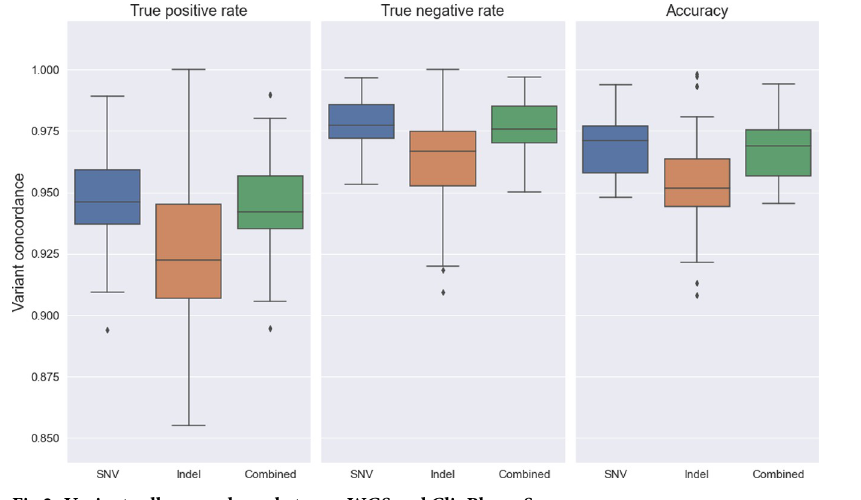
Fig 2. Variant call concordance between WGS and